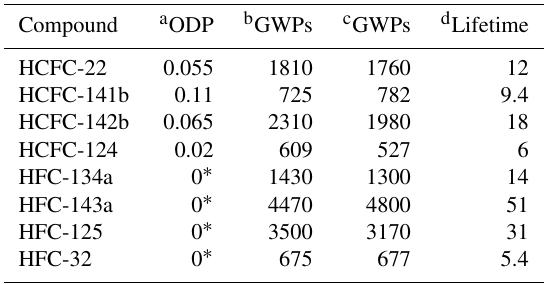
Table 1. Steady-state atmospheric lifetimes (year), ozone deple- tion and global warming potentials (100-year time horizon) for the HCFCs and HFCs discussed in this